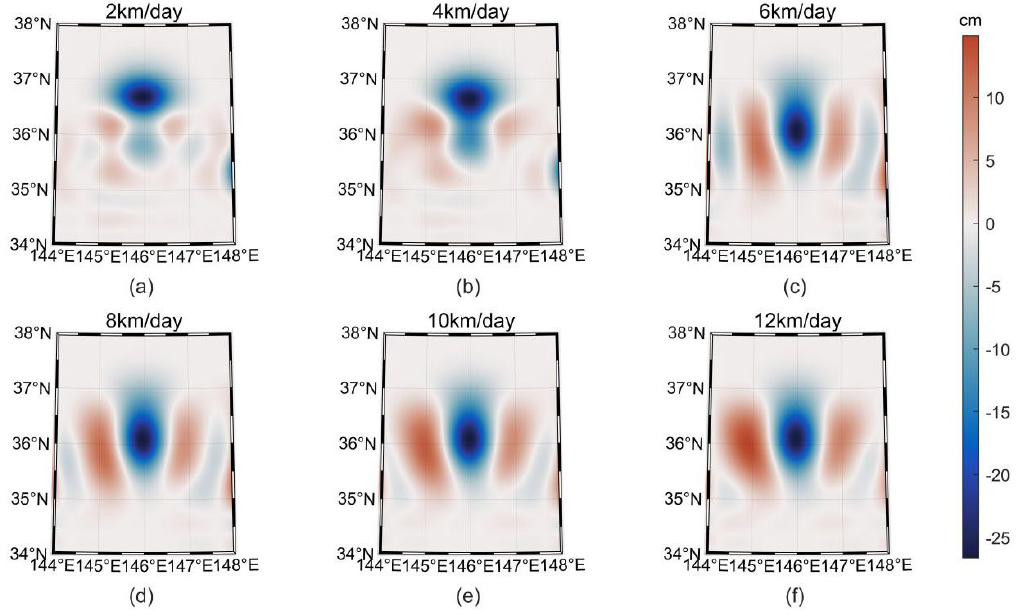
Figure 11. Absolute error distribution changes corresponding to westerly moving velocities ranging from 0 to 12 km/day. ( a – f ) Westerly moving velocities are from 0 to 12 km/day, respectively. To quantitatively analyze the change of this error, the cumulative absolute error distribution curve at different westerly movement speeds is drawn, as shown in Figure 12, and the corresponding cumulative errors are shown in Table 4.